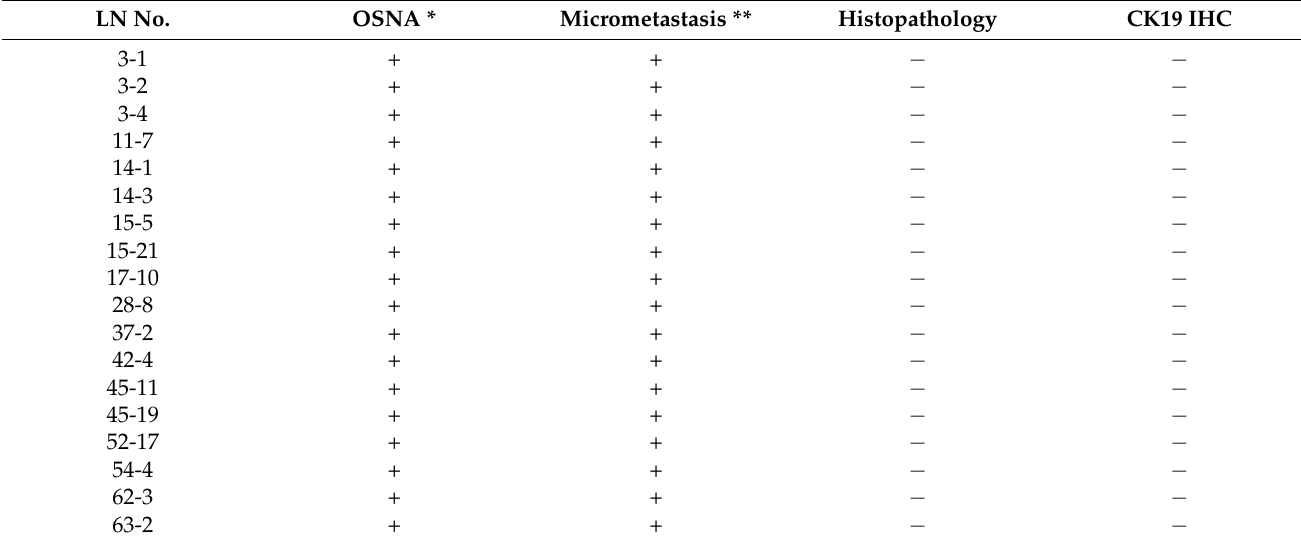
Table 2. Detailed view of OSNA positive/histopathological negative lymph nodes. LN No.